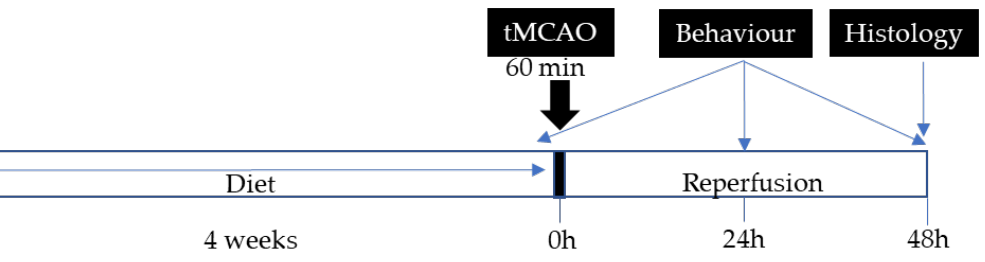
Figure 1. Representative scheme showing the procedure followed to study the effect of HFDs with distinct fatty acid compositions on mice subjected to transient middle cerebral artery occlusion (tMCAo).